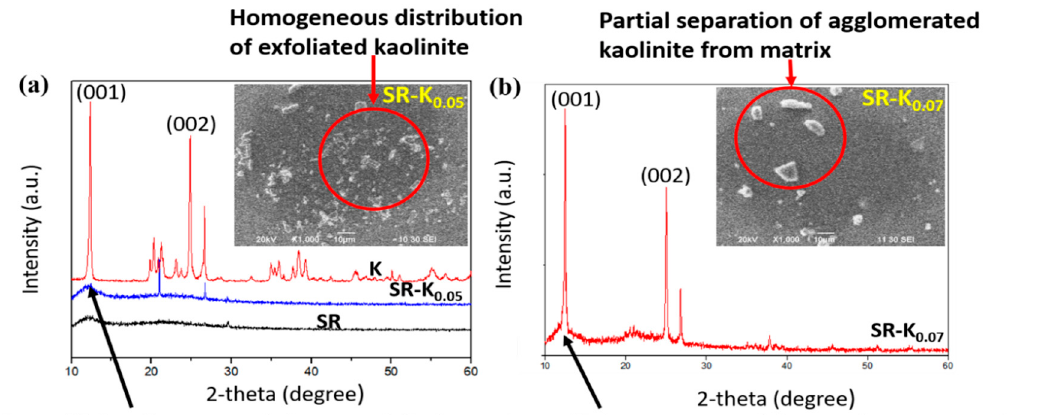
Figure 2. ( a ) XRD patterns of SR, K, and SR-K 0.05 (Inset shows the SEM micrograph of SR-K 0.05 with scale bar of 10 µm. The morphological feature and disappearance of crystallinity indicates exfoliation of kaolinite); ( b ) XRD pattern of SR-K 0.07 (Inset shows the SEM micrograph of SR-K 0.07 with scale bar of 10 µm. Morphology and characteristic XRD peaks strongly support agglomeration and phase separation of kaolinite from the matrix.).